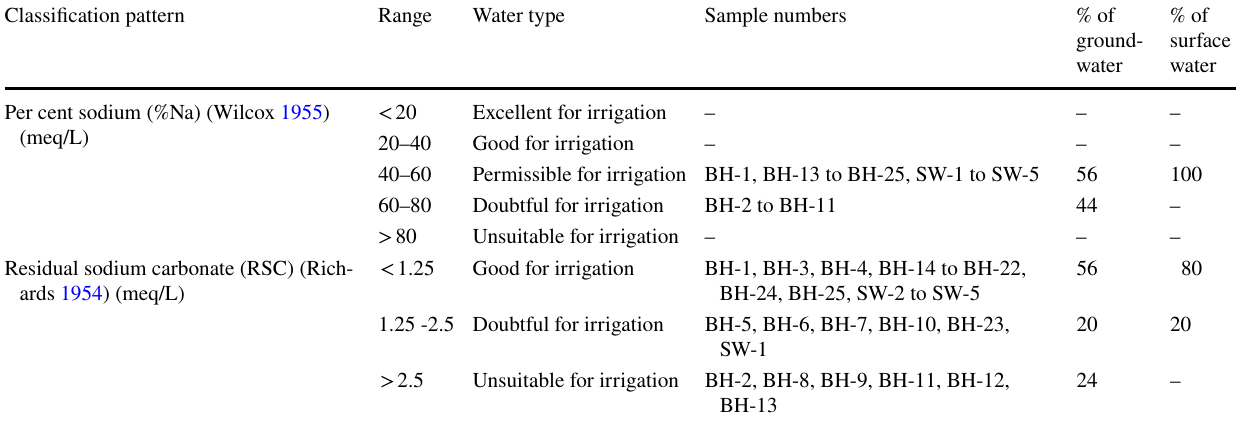
Table 8 Classification of water quality for irrigation on the basis of %Na and RSC in the study region, Telangana State, South India